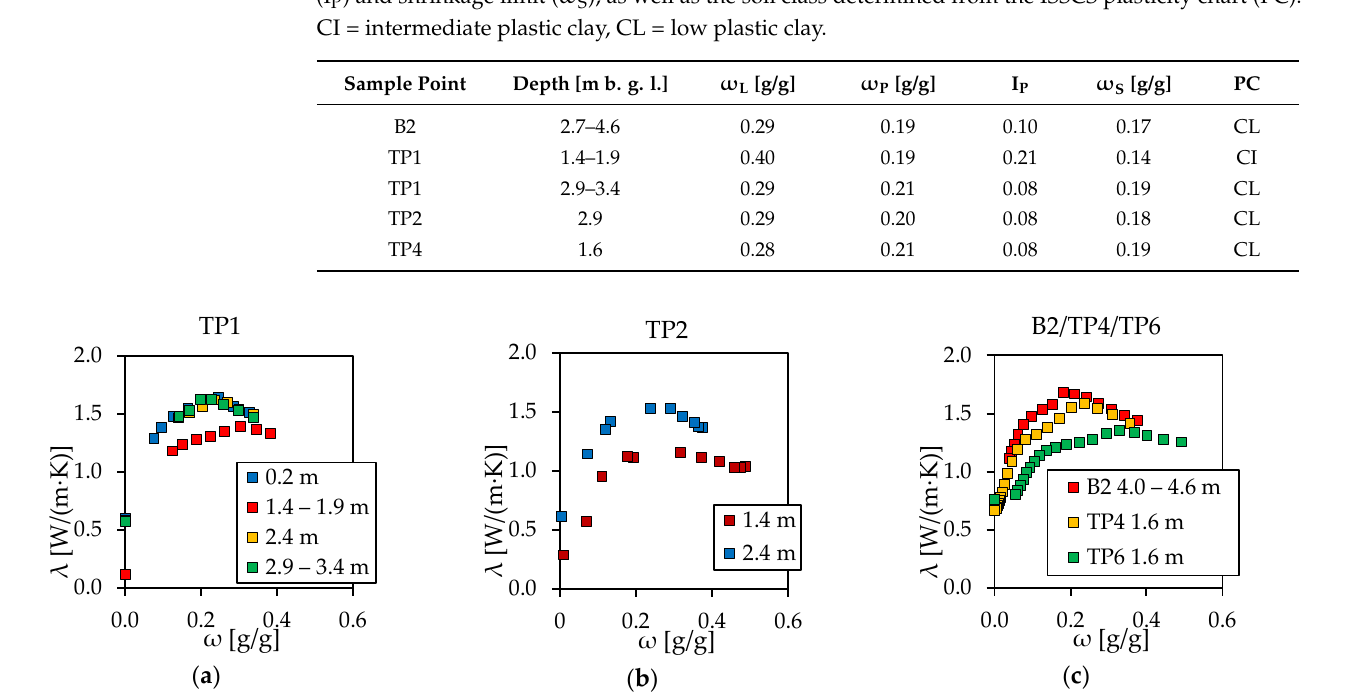
Figure 3. Results of thermal conductivity ( λ ) measurements as a function of the gravimetric water content ( ω ) using the evaporation method for samples of ( a ) TP1, ( b ) TP2 and ( c ) B2, TP4 and TP6. A maximum of one measuring point per 24 h is displayed.